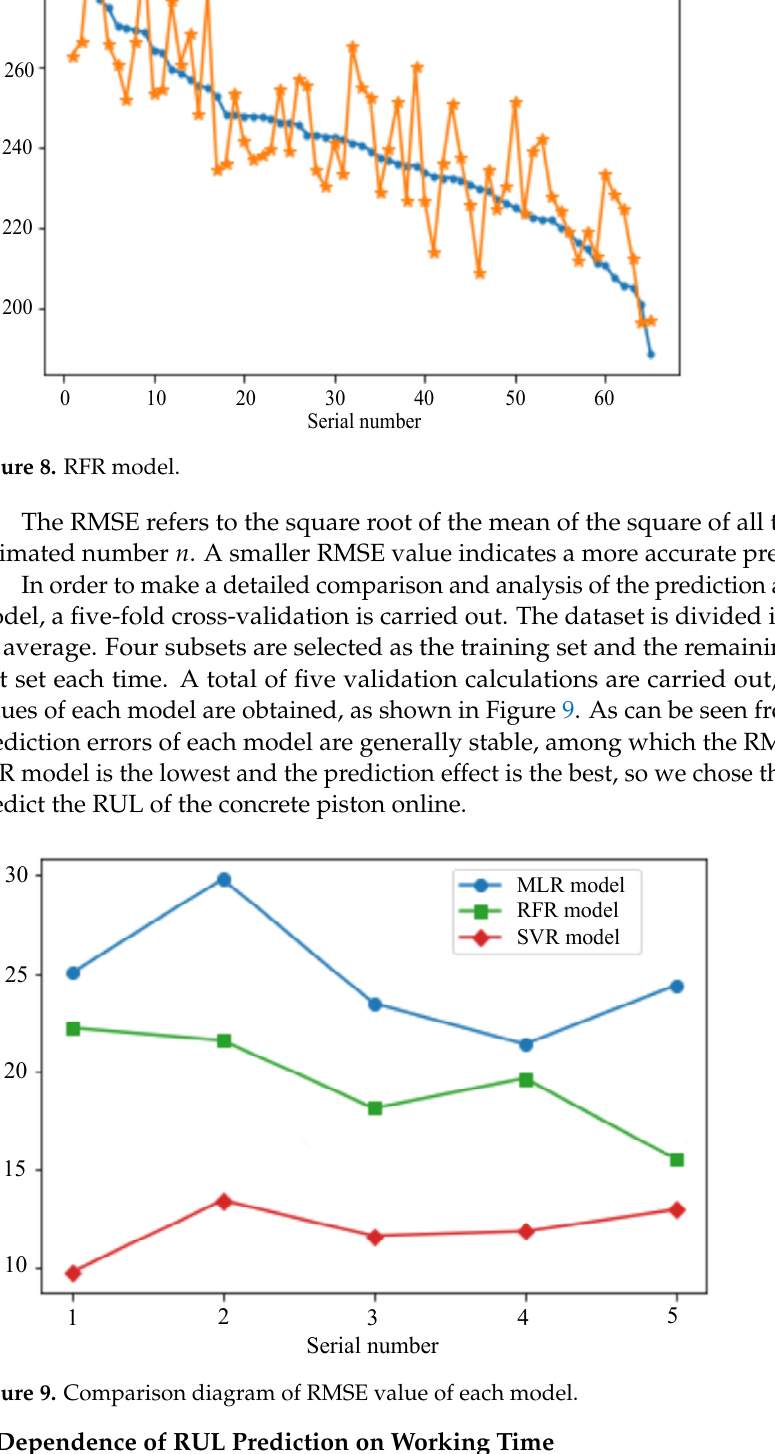
Figure 9. Comparison diagram of RMSE value of each model.